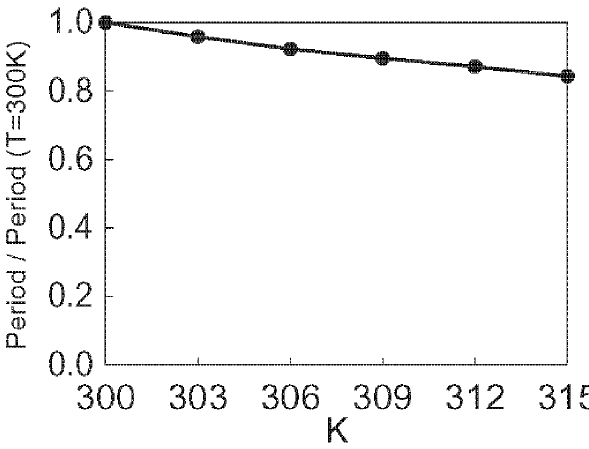
Figure 9. Temperature compensation of the oscillation period length of the phosphorylation level p(t). The period length is normalized by its value at 300K.